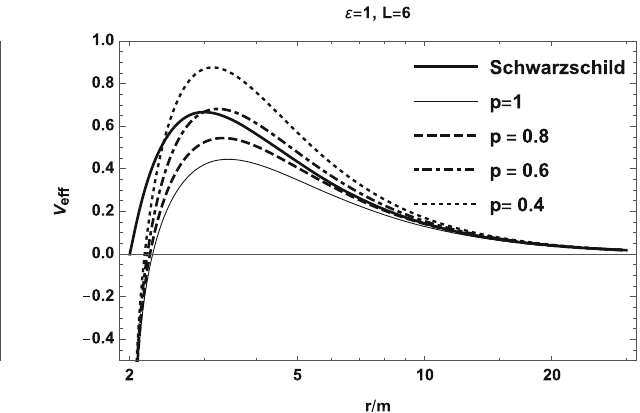
plotted for γ = 1 . 2 and various values of p . The effective potential for Schwarzschild (i.e. γ = 1 and p = 1) is included for reference. R ISCO is given in units of m